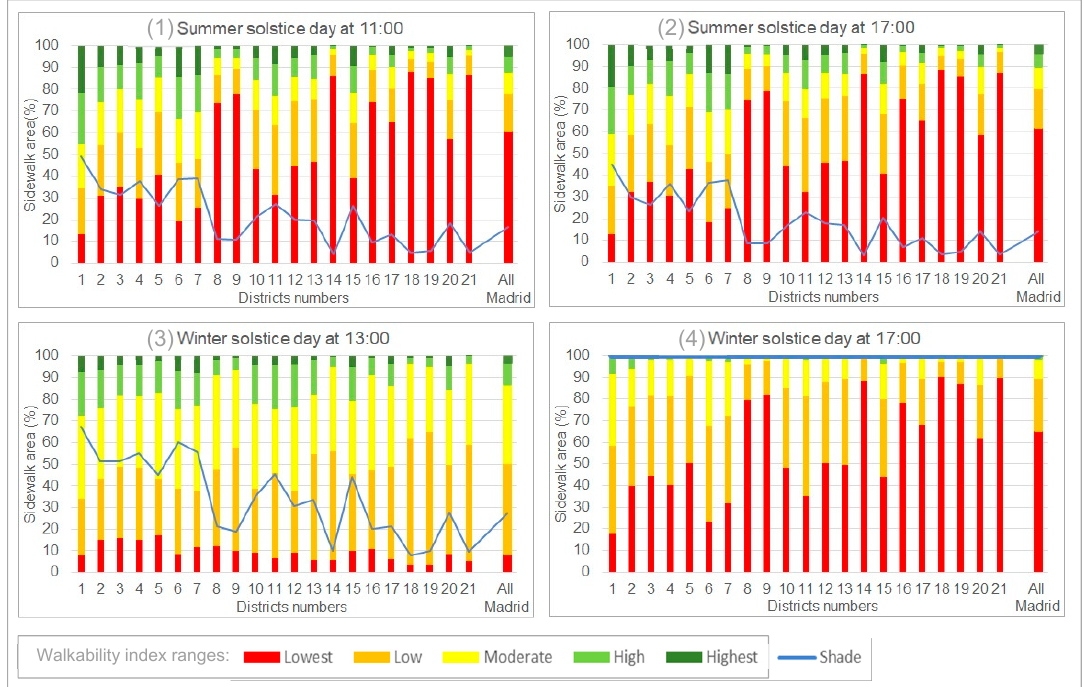
Figure 3. Percentages of WI ranges and shaded areas in each of the 21 districts in Madrid.